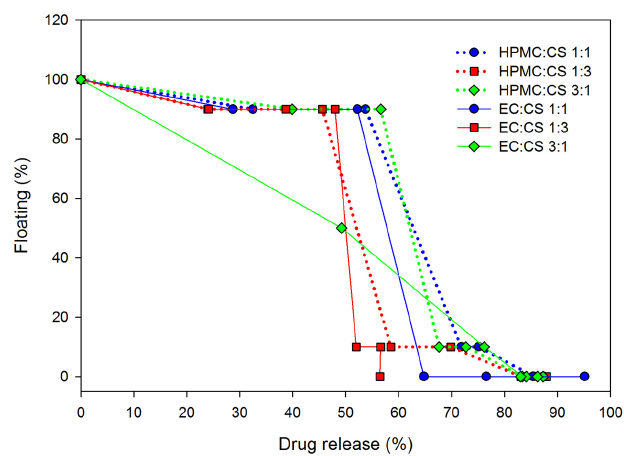
FIGURE 7 - Relation between floating ability and drug release of microparticles. CS: chitosan; HPMC: hydroxypropyl methylcellulose; EC: